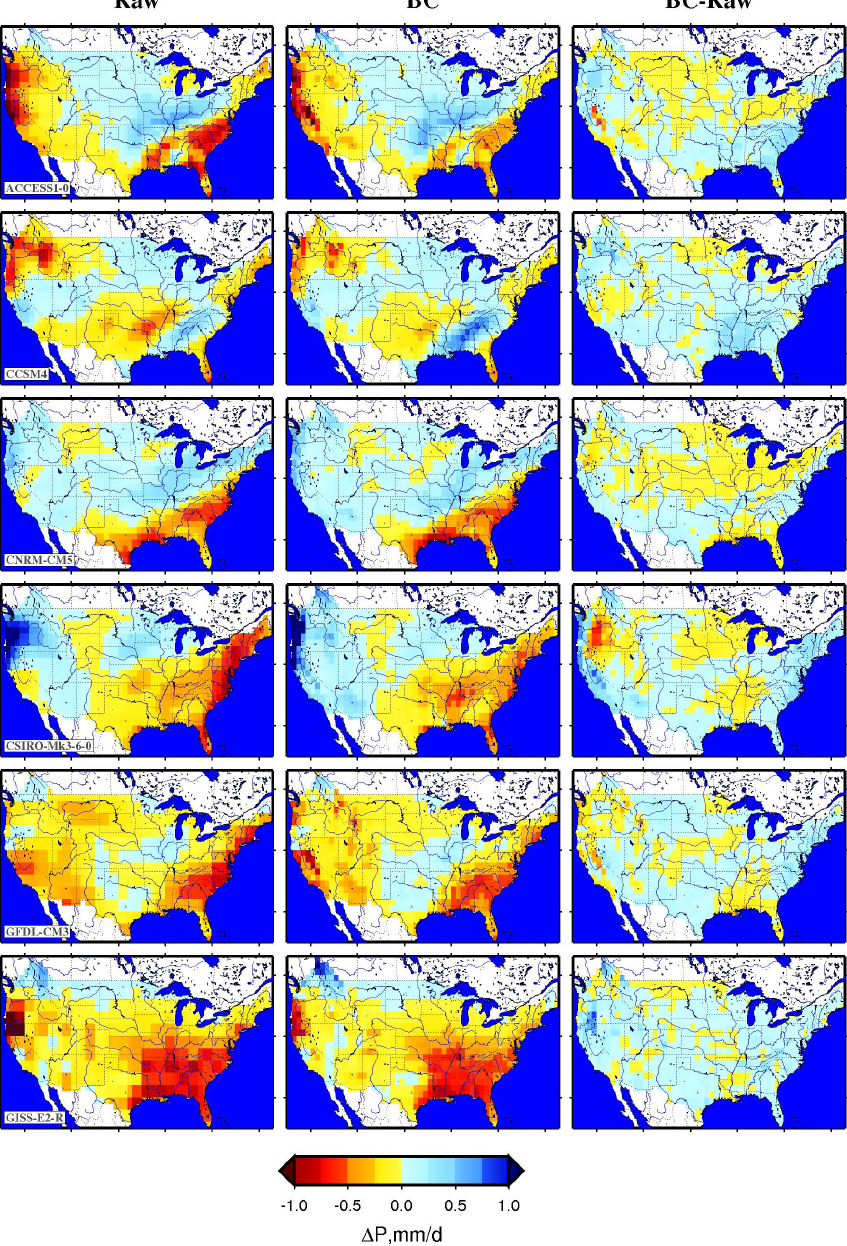
Fig. 4. For GCMs 1–6, the change in mean DJF precipitation between 1979–1993 and 1994–2005 for the raw GCM output (left column) and bias corrected GCM output (center); the difference between the two is in the right